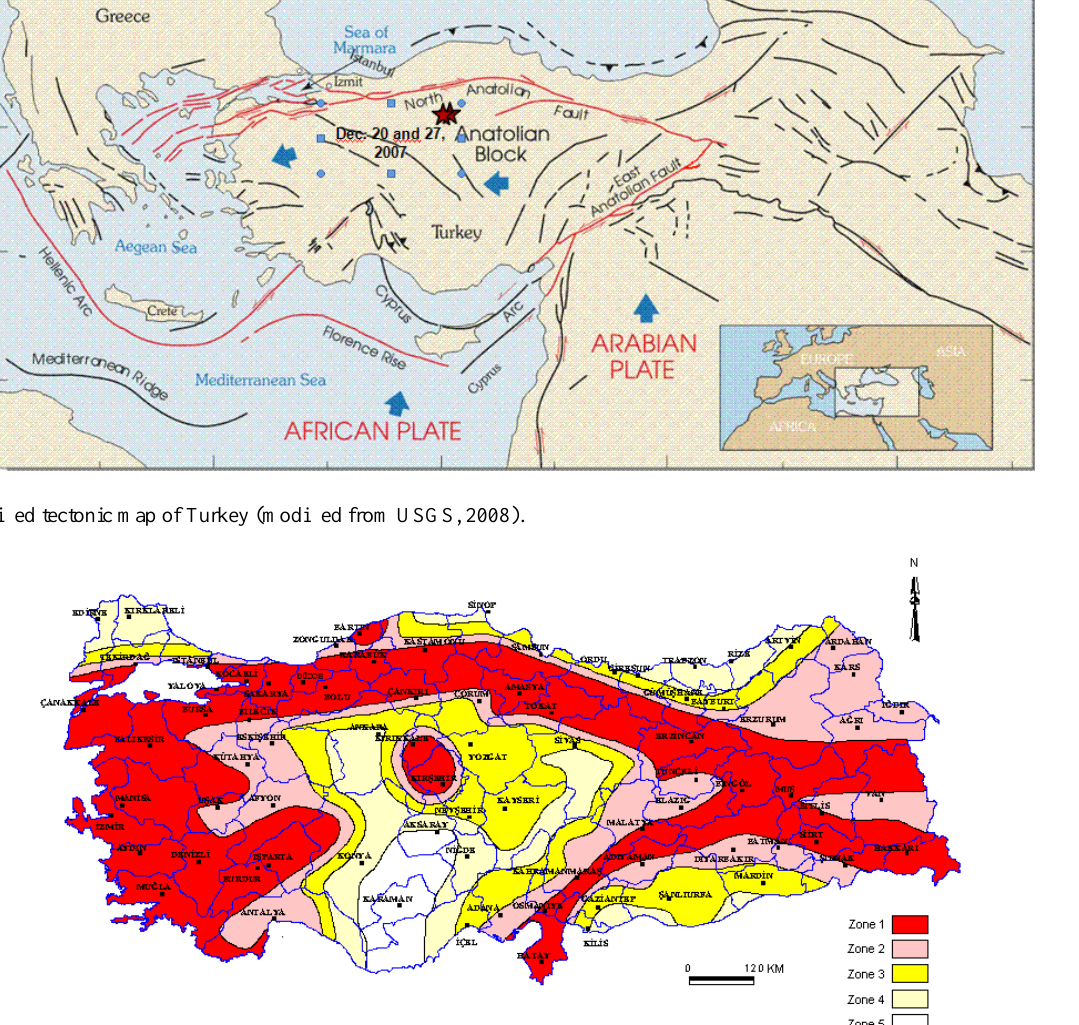
Fig. 2. Seismic zoning map of Turkey (http://www.deprem.gov.tr,